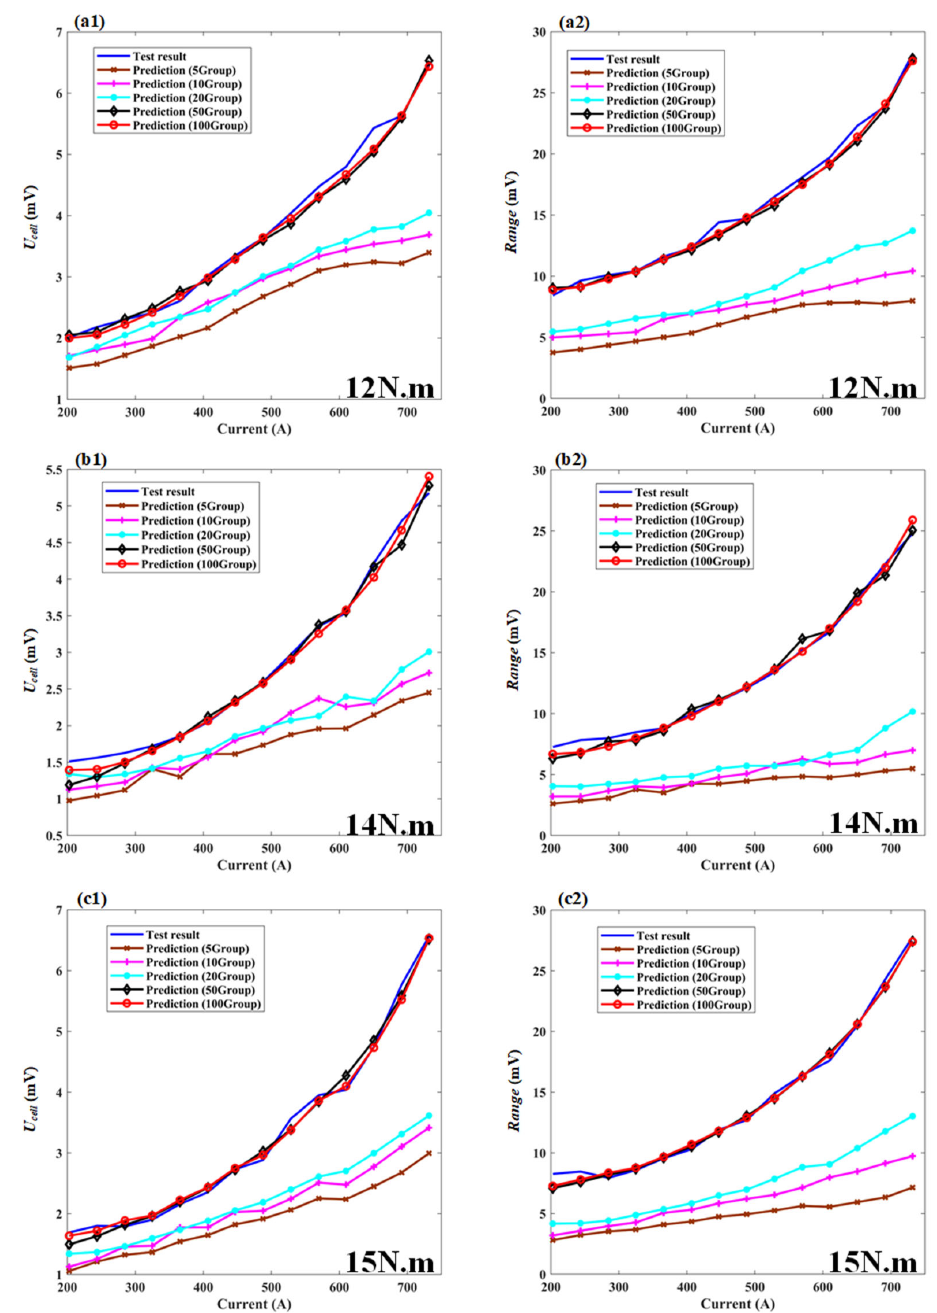
Figure 8. Comparison between the predicted voltages under different grouping strategies and the experimental voltages of 100 cells under varied load currents and assembly torques: ( a1 , b1 , c1 ) for U cell ; ( a2 , b2 , c2 ) for range cell